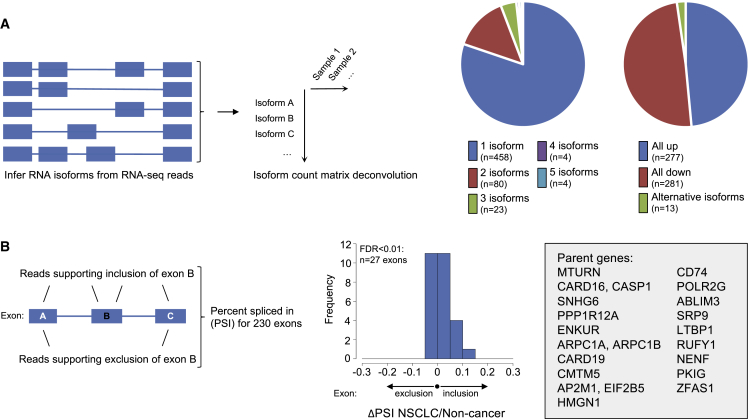
Alternative Splicing and Exon Skipping in TEPs of Patients with NSCLC(A) Schematic figure represents the development of an isoform count matrix that contains, per sample for each expressed RNA isoform, the number of reads supporting that particular isoform. RNA isoforms were inferred from the RNA-seq data using MISO. The isoform count matrix is employed for non-cancer versus NSCLC differential splicing analysis. The left pie chart indicates the gene loci (in total n = 571) with one or more differentially spliced isoforms (encoded in the color bars). Two gene loci with 10 isoforms each were not indicated. The right pie chart indicates the number of gene loci with multiple differentially spliced isoforms that show concordant up (blue box), concordant down (red box), or both directions (alternative isoforms; green box).(B) Schematic figure represents the MISO algorithm mapping exon-skipping events, thereby calculating the percent spliced in (PSI) value. Subsequently, ANOVA statistics were applied to individual exons with sufficient coverage in the dataset (n = 230) comparing read levels in non-cancer and NSCLC individuals, and assessed for overall in- or exclusion by calculation of the ΔPSI value. Histogram shows the direction of the PSI value for 27 exons with FDR < 0.01 (positive PSI values favors inclusion in NSCLC, whereas negative PSI values favors exclusion in NSCLC). Individuals gene names associated with the 27 exons are listed in the box.